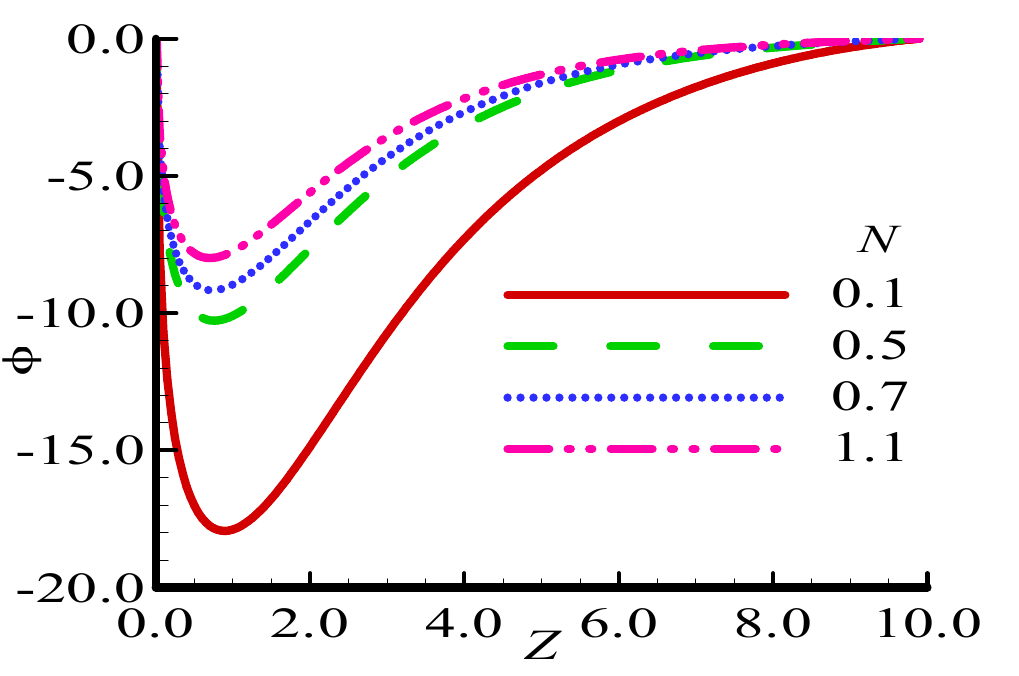
Figure 13. Outcomes of radiation parameter 𝑁 on temperature distribution 𝜃 when 𝑁𝑏 =